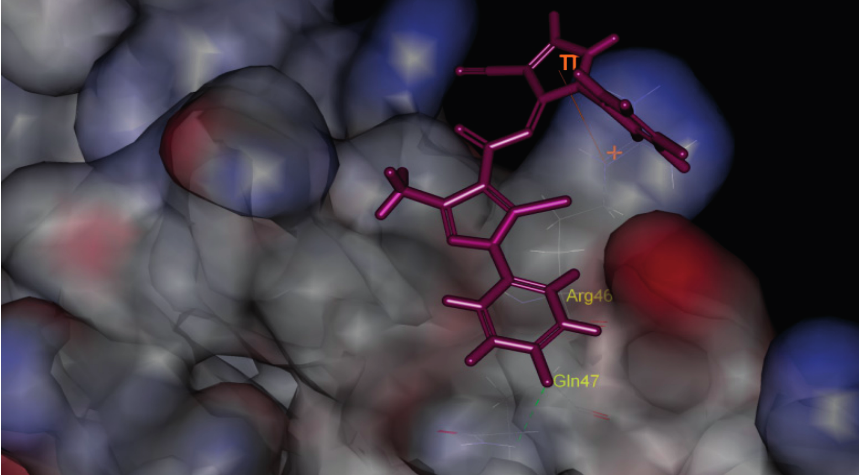
Figure 4. Docking model of compound 3p with TMV PC. It is nicely bound to the TMV PC one H-bond (GIn47-F:2.49 Å, 109.02°) and has a π -cation interaction (4.65